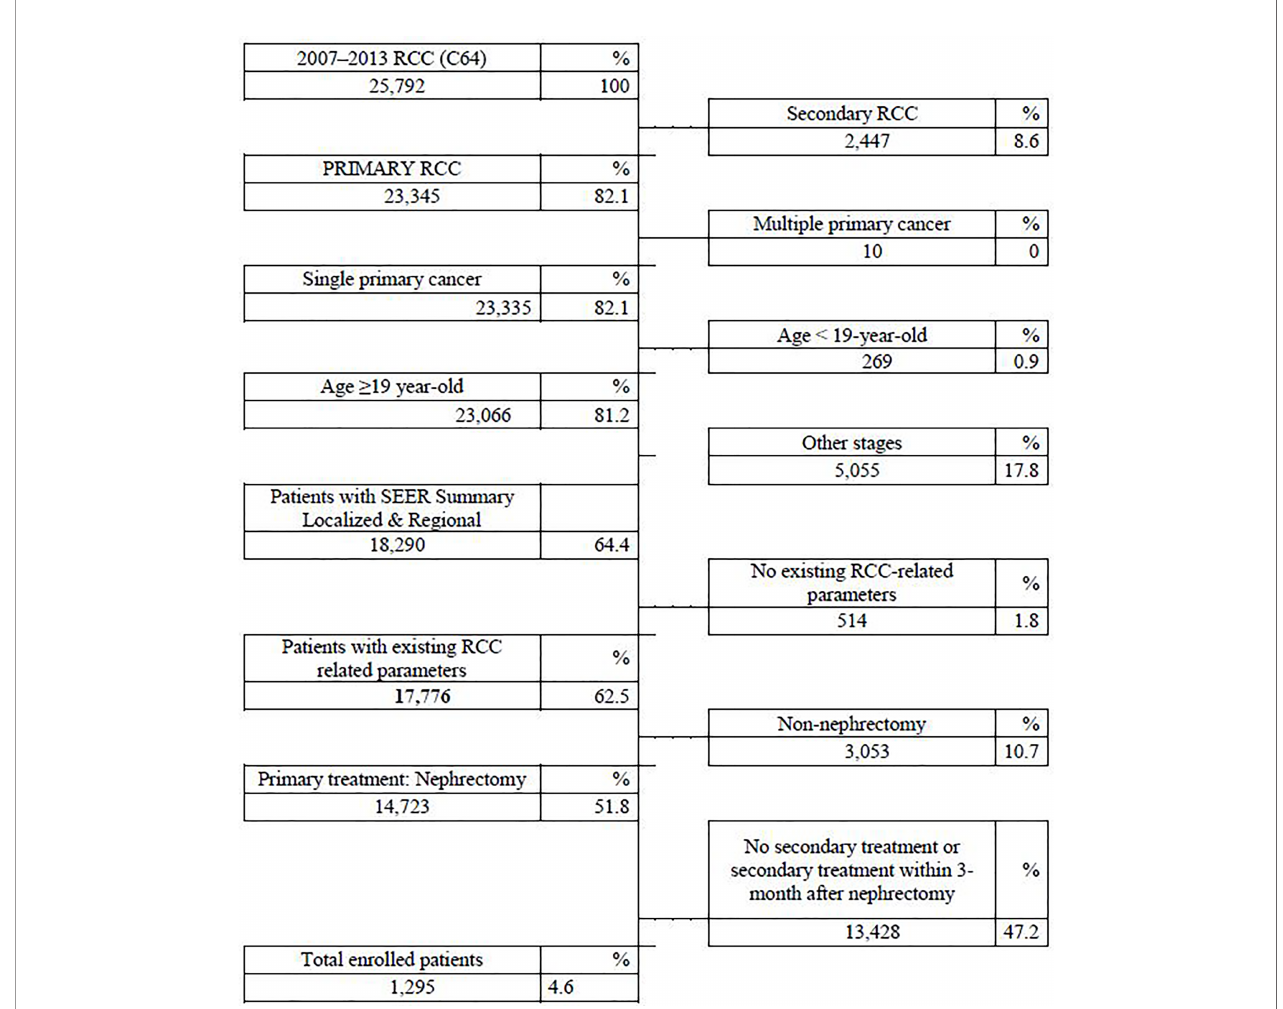
FIGURE 1 | Flowchart of patient selection according to inclusion and exclusion criteria in the National Insurance Policy